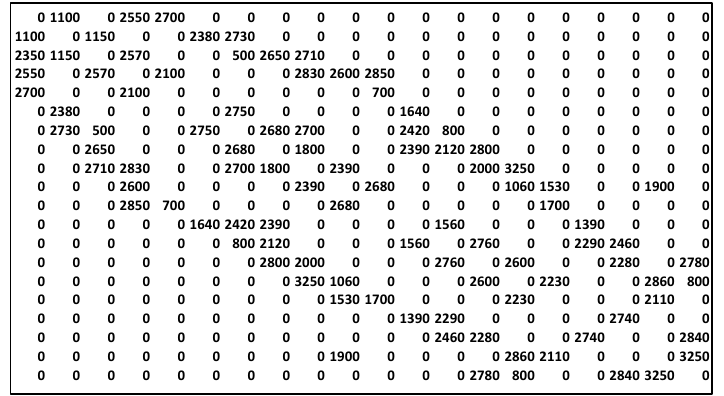
Figure 10. The latency values for the edges of graph B. Figure 11 presents a graph of the Pareto front while optimizing using only bandwidth and latency objective functions.